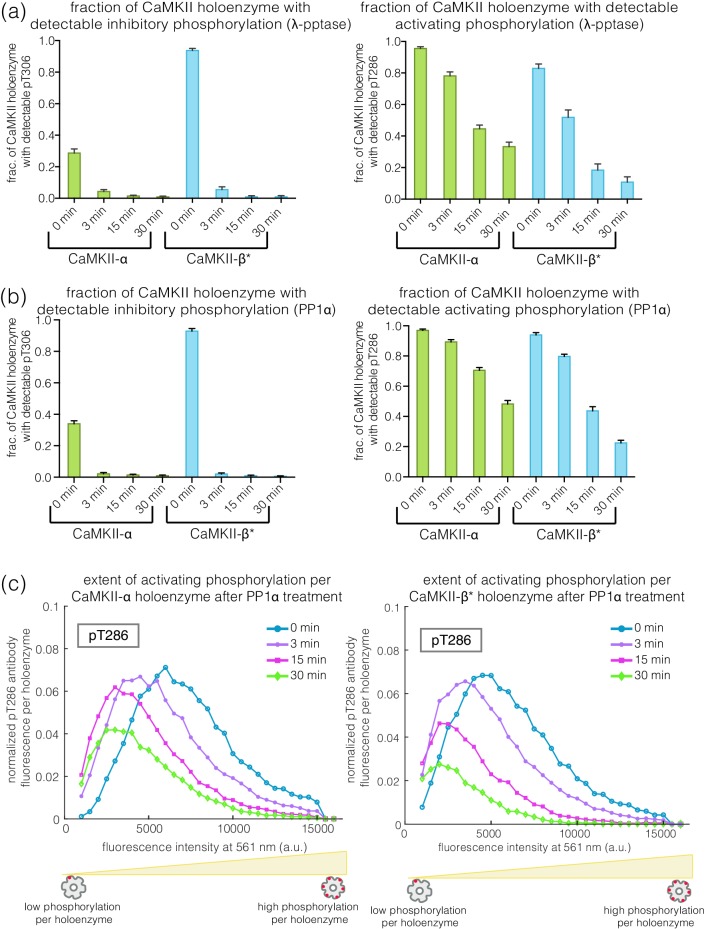
Effect of phosphatases on dephosphorylation kinetics when kinase activity is switched off.(a) Fraction of CaMKII-α/β* holoenzymes with detectable phosphorylation at Thr 305/306 (left) and Thr 286 (right) after 0, 3, 15, or 30 min of treatment with λ-phosphatase, when the kinase activity is switched off. (b) Same as (a), but PP1α phosphatase was used. (c) Intensity distribution for pThr 286 (561 nm) for CaMKII-α (left panel) and CaMKII-β* (right panel) holoenzymes with detectable phosphorylation at Thr 286 after 0, 3, 15, or 30 min of PP1α treatment (see Materials and methods for details of normalization).